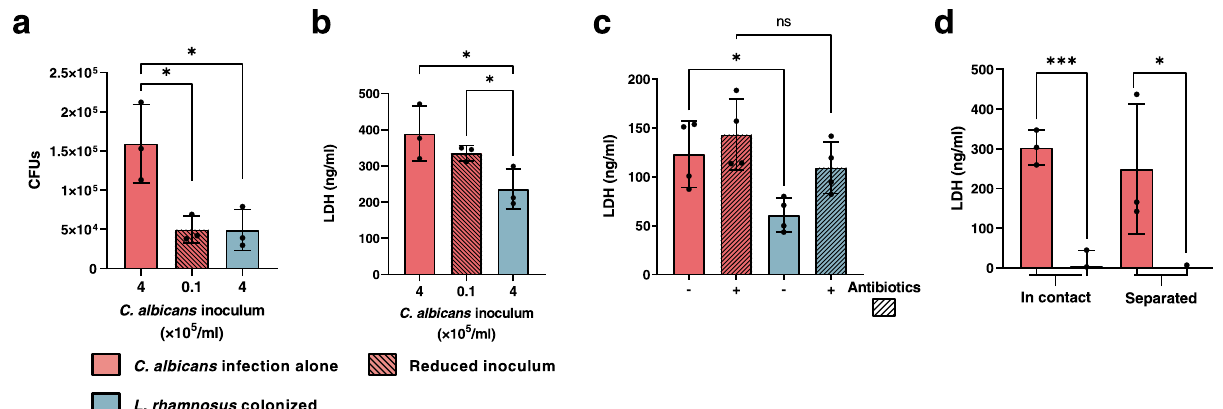
Fig. 1 Reduced C. albicans inocula cause signi fi cant damage compared to C. albicans in the presence of live L. rhamnosus that reduces pathogenicity contact-independently. a Fungal burden assessed by quanti fi cation of C. albicans CFUs and b the necrotic cell damage of IECs quanti fi ed by LDH activity in supernatants at 24 h post infection (hpi). Cells were infected with a C. albicans infection inoculum (4 × 10 5 /ml) in the presence and absence of L. rhamnosus , or with a reduced infection inoculum (1 × 10 4 /ml) in the absence of L. rhamnosus ( n = 3 biological repeats; L. rhamnosus colonized A * = p 0.0276, B * = p 0.0434 reduced inoculum A * = p 0.0225; B * = p 0.0434). c , d Necrotic cell damage of IECs quanti fi ed by LDH activity in supernatants at 24 hpi, ( c ) in the presence and absence of L. rhamnosus colonization and antibiotic treatment with Gentamicin and Penicillin/Streptomycin at 4 hpi ( n = 4 biological repeats; * = p 0.0173ns = 0.184), or ( d ) in the presence and absence of L. rhamnosus colonization where L. rhamnosus was in direct contact with the cells or physically separated using a transwell insert with a 0.4 µ m pore size ( n = 3 biological repeats; *** = p 0.0009, * = 0.048). Bars represent the mean and standard deviation of the independent experiments, dots represent the mean of the technical replicates of the individual experiments, biological repeats were compared for signi fi cance using an unpaired t-test (two-tailed, one-sample), * = p ≤ 0.05, ** = p ≤ 0.01, *** = p ≤ 0.001. Source data are provided as a Source Data fi